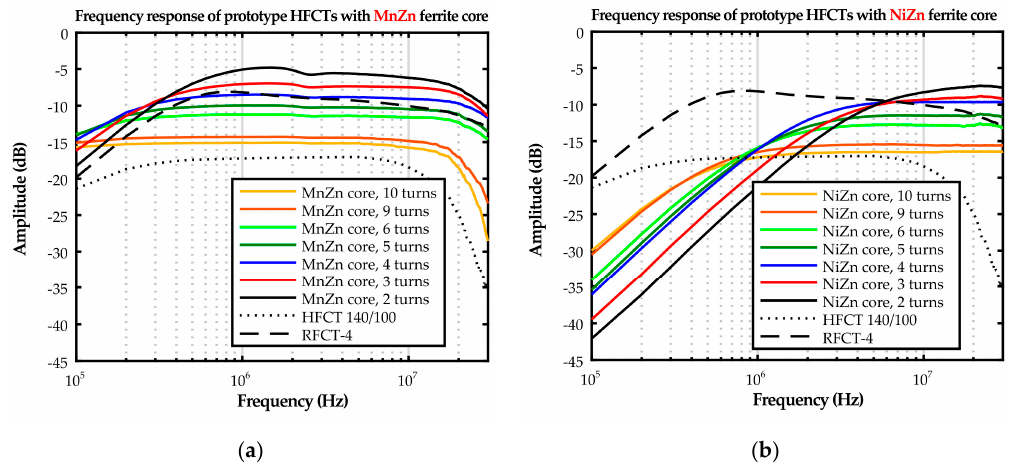
Figure 15. Frequency response of the prototype HFCT sensors depending on the number of turns N and the core material used: ( a ) MnZn soft ferrite, ( b ) NiZn soft ferrite, compared with frequency response of commercial HFCT sensors (RFCT-4 and HFCT 140/100).